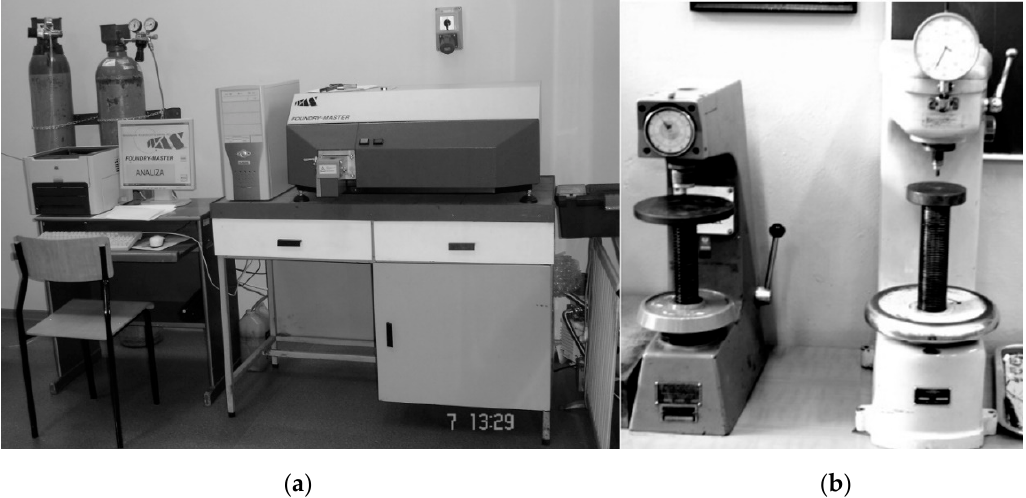
Figure 8. Instruments for metallographic measurements: ( a ) Foundry Master device; ( b ) hardness testers produced by Vickers and Rockwell [29].